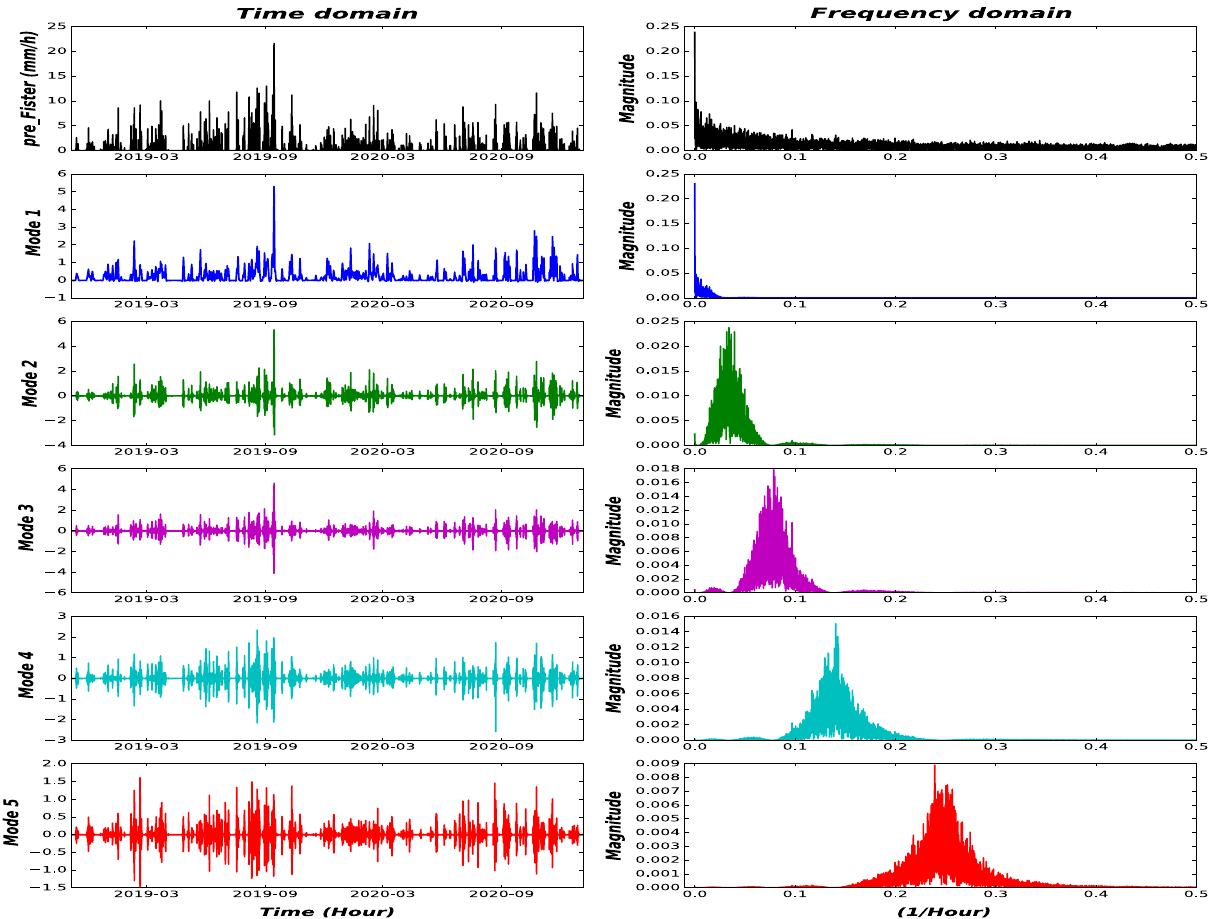
Figure 6. VMD decomposition of precipitation time-series from Fister